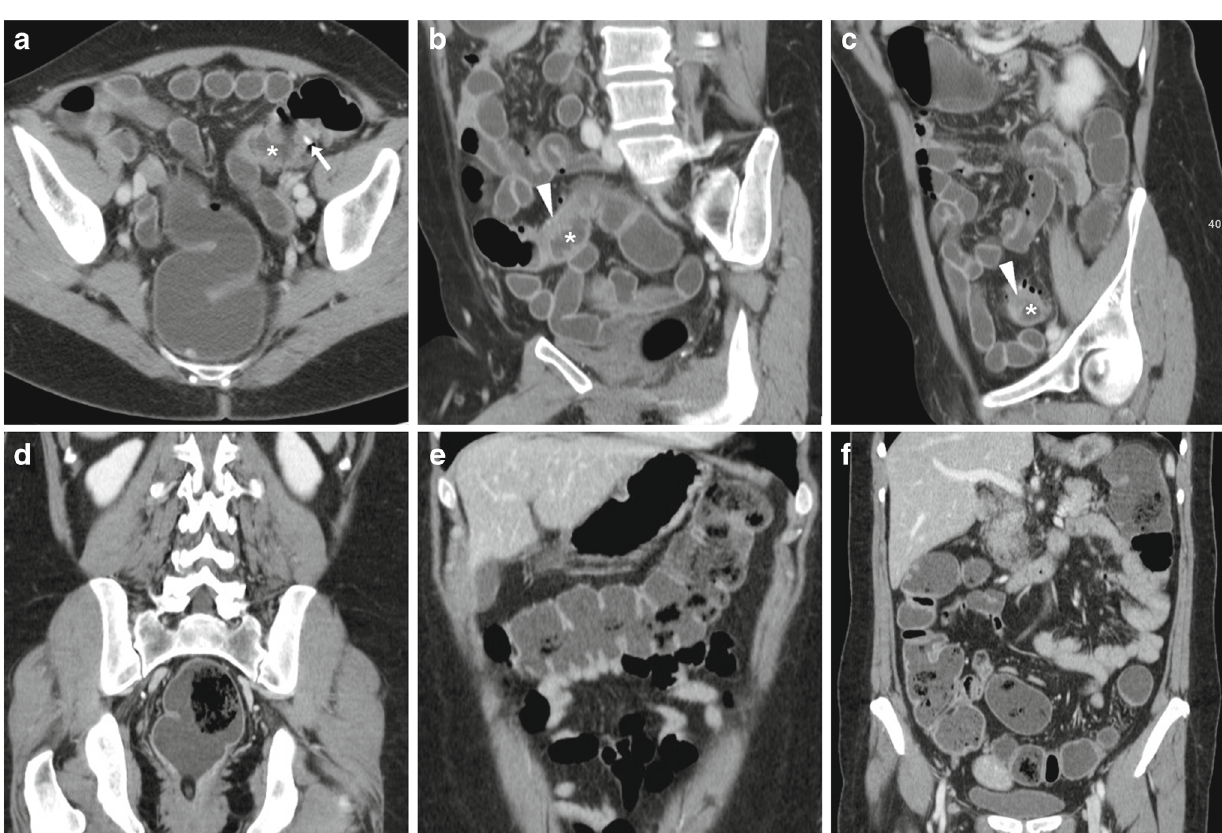
Fig. 16 Common pitfalls of WE-MDCT. a – c Localised poor distension of the proximal sigmoid colon (*) with apparent eccentric mural thickening (arrowheads) in a 61-year-old female with history of iatrogenic perforation during polypectomy treated with endoscopic clipping (arrow in a ). Clinical and endoscopic follow-up was